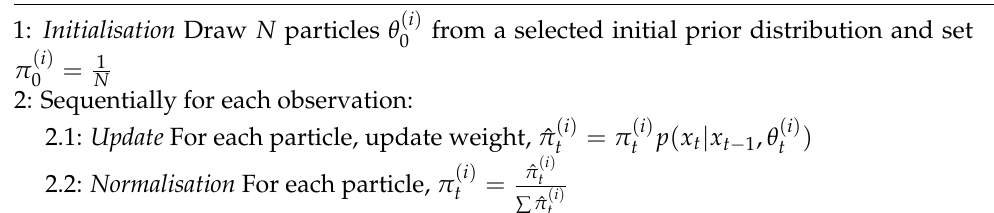
Algorithm 1 Basic particle filtering